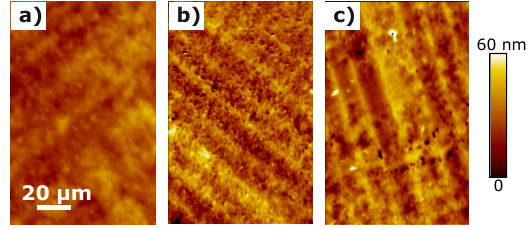
Figure 1. Surface topographies by WLI: a) an untreated Al905 surface after SPDT with a rms roughness of R q = 10 : 9nm, b) argon ion treatment (1.5keV, etching depth: 330nm) results in considerable roughening with R q = 21 : 0nm, and c) nitrogen ion treatment (1.5keV, etching depth: 1 (cid:22) m) with an almost pre- served initial topography at R q = 12 :